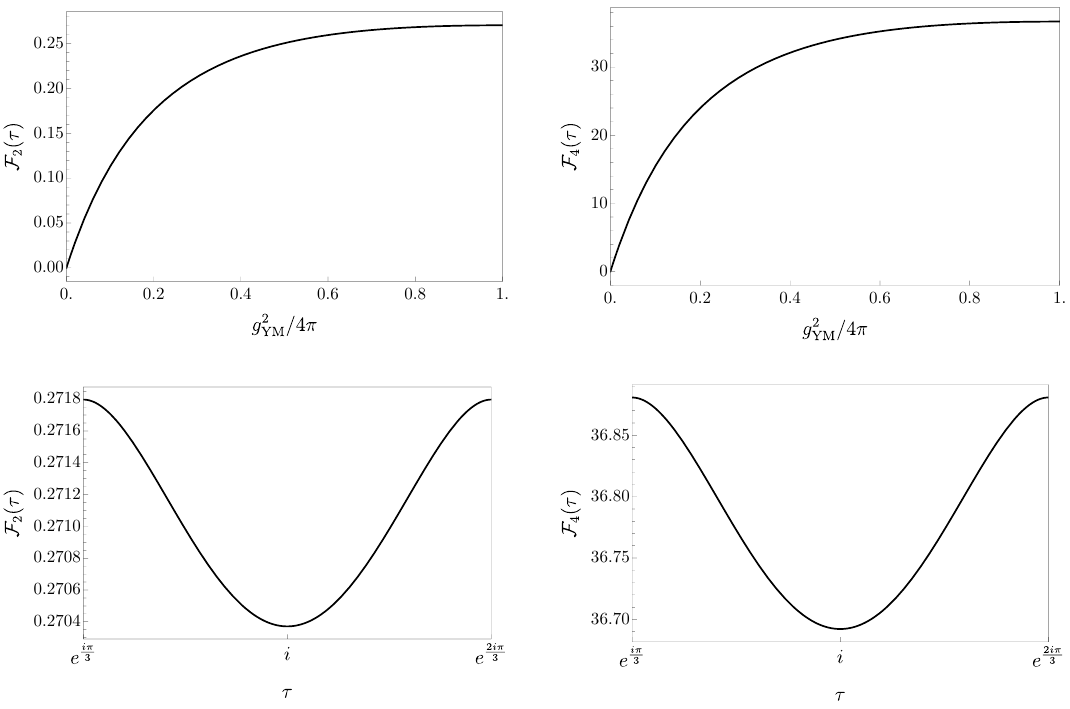
( above ), and as a function YM